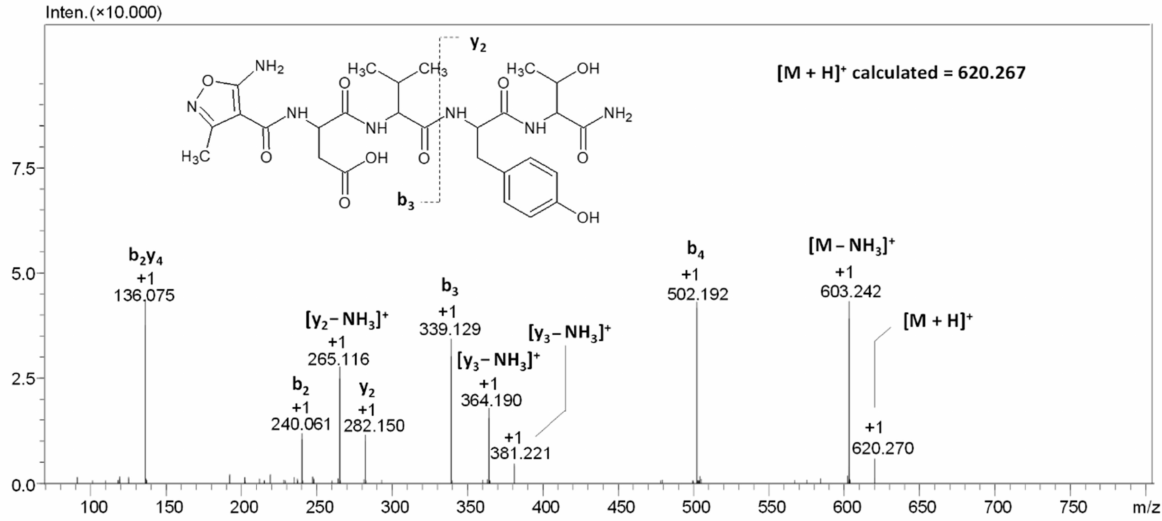
Figure 3. ESI-MS/MS spectrum of compound 1 . Parent ion m / z 620.270, collision energy 20–40